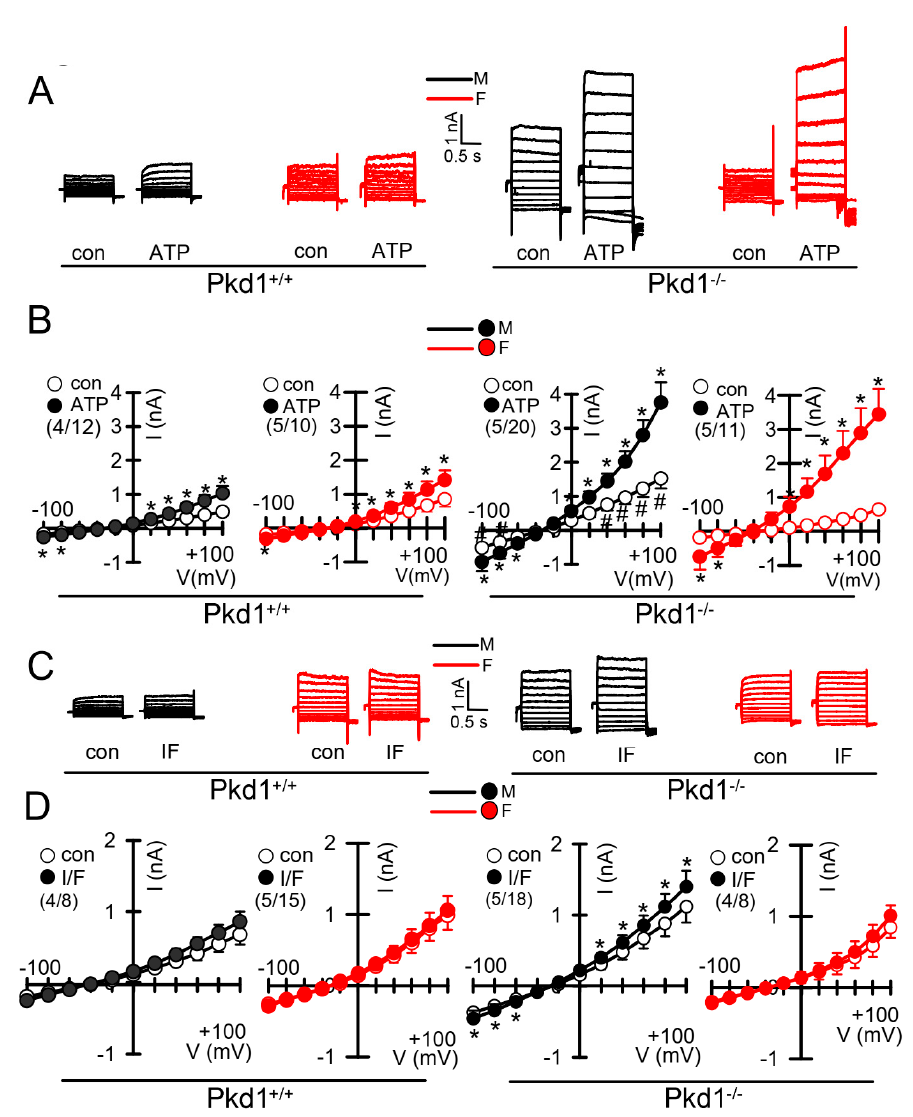
Figure 4. Whole cell patch clamp experiments in primary renal epithelial cells from male and female Pkd1 +/+ and Pkd1 − / − mice. ( A ) Original whole cell overlay currents of basal and ATP (50 µM)-activated currents in male and female Pkd1 +/+ and Pkd1 − / − mice. ( B ) Summary i/v curves of basal and ATP-activated currents indicating larger ATP-activated currents in Pkd1 − / − mice and larger basal currents in male Pkd1 − / − mice. ( C ) Original overlay currents of basal and IF (100 µM IBMX and 2 µM forskolin)-activated currents in male and female Pkd1 +/+ and Pkd1 − / − mice. ( D ) Summary i/v curves of basal and IF-activated currents indicating small but significant IF-activated currents in male Pkd1 − / − - mice. Mean ± SEM (number of animals/number of experiments in each series). * Significant activation by ATP and IF, respectively ( p < 0.05; paired t-test). # Significant difference compared to other basal currents ( p < 0.05; ANOVA and Tukey’s post-hoc test).